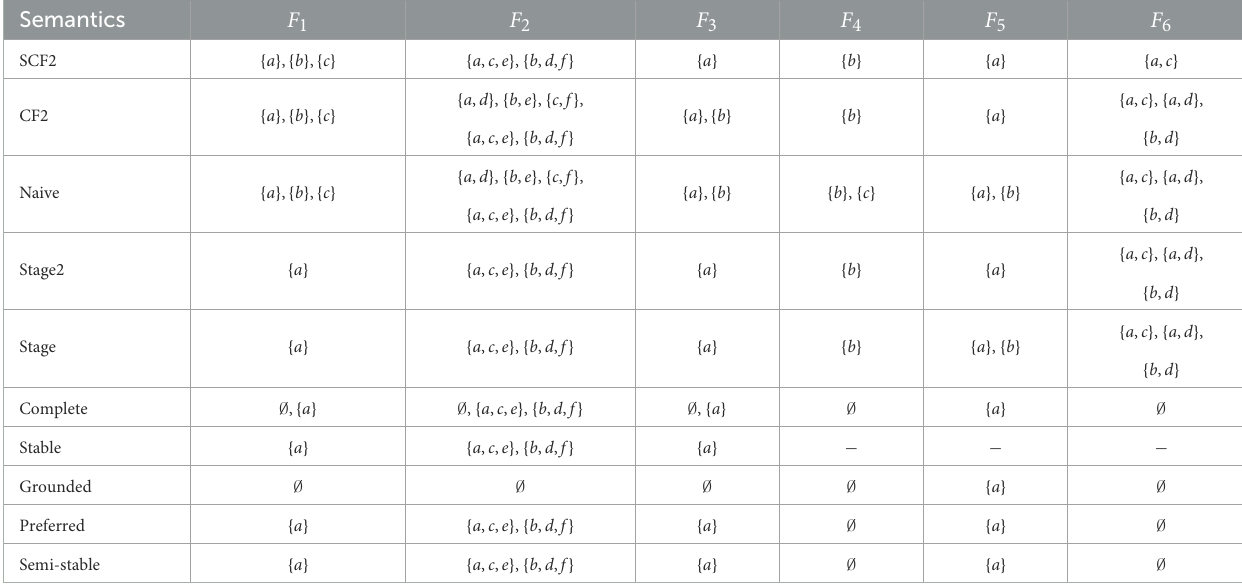
TABLE 1 Extensions of example AFs according to SCF2 and the semantics introduced in Section